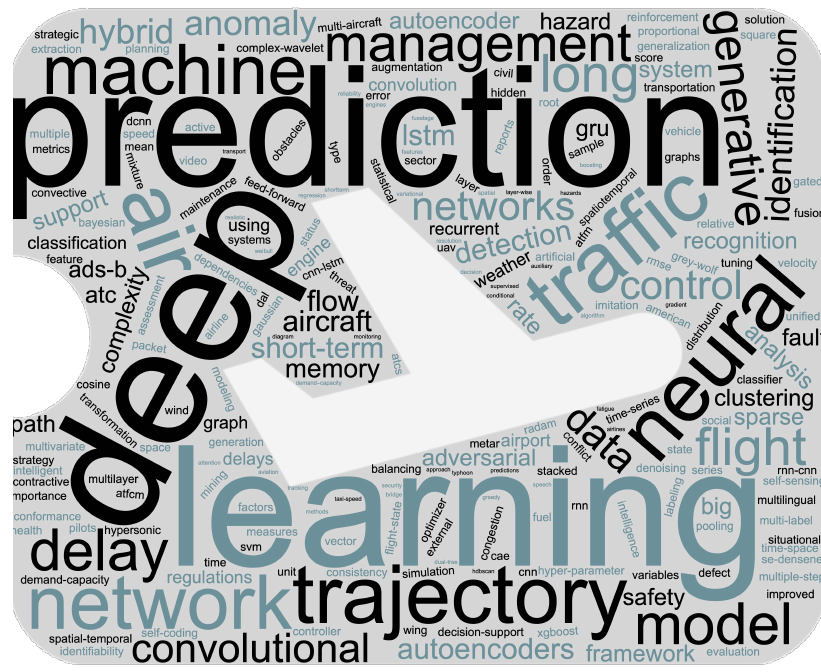
Figure 10. Word cloud of